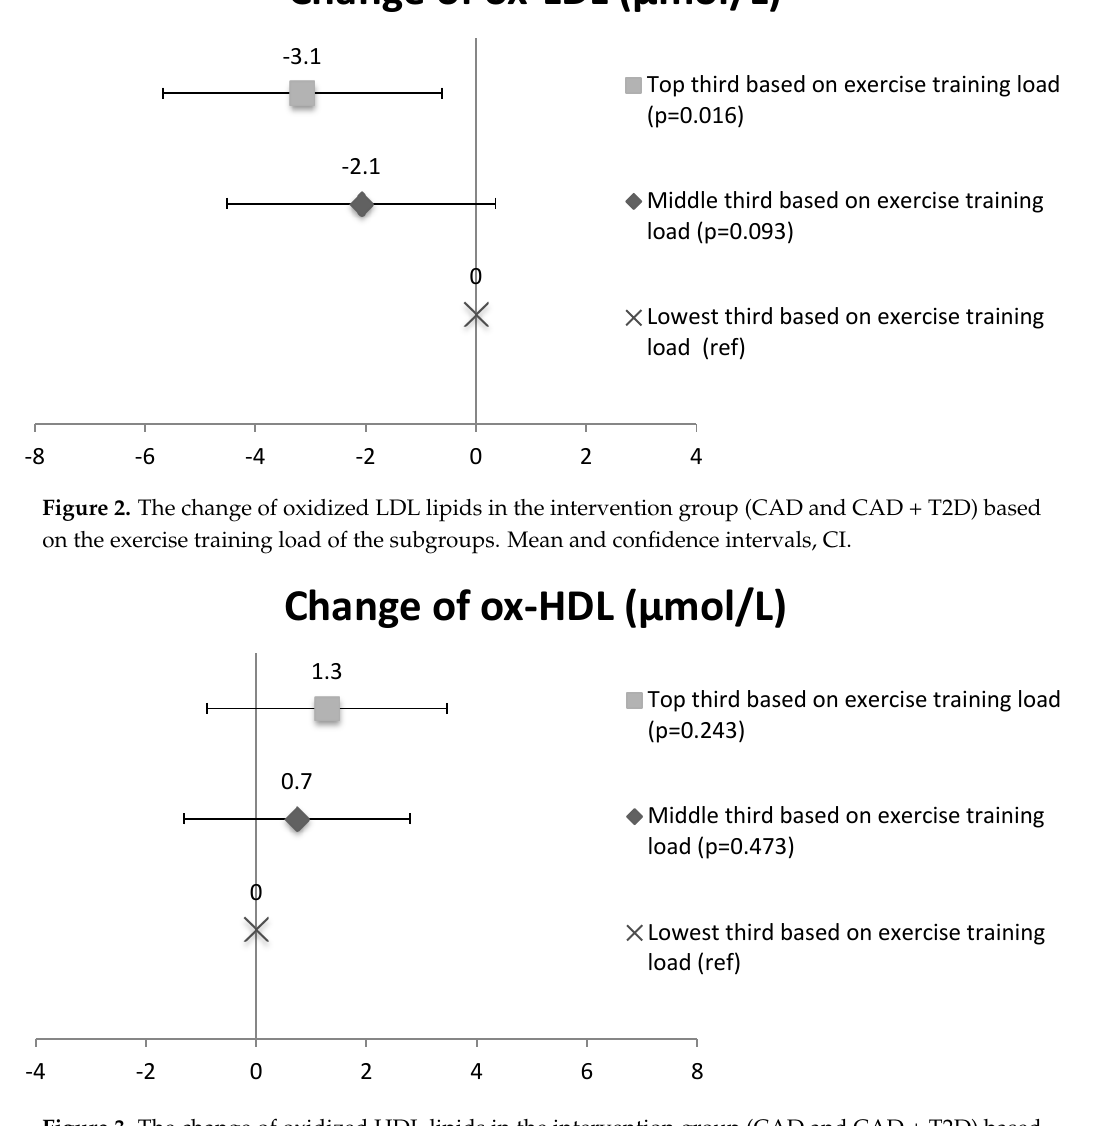
Figure 3. The change of oxidized HDL lipids in the intervention group (CAD and CAD + T2D) based on the exercise training load of the subgroups. Mean and CI.